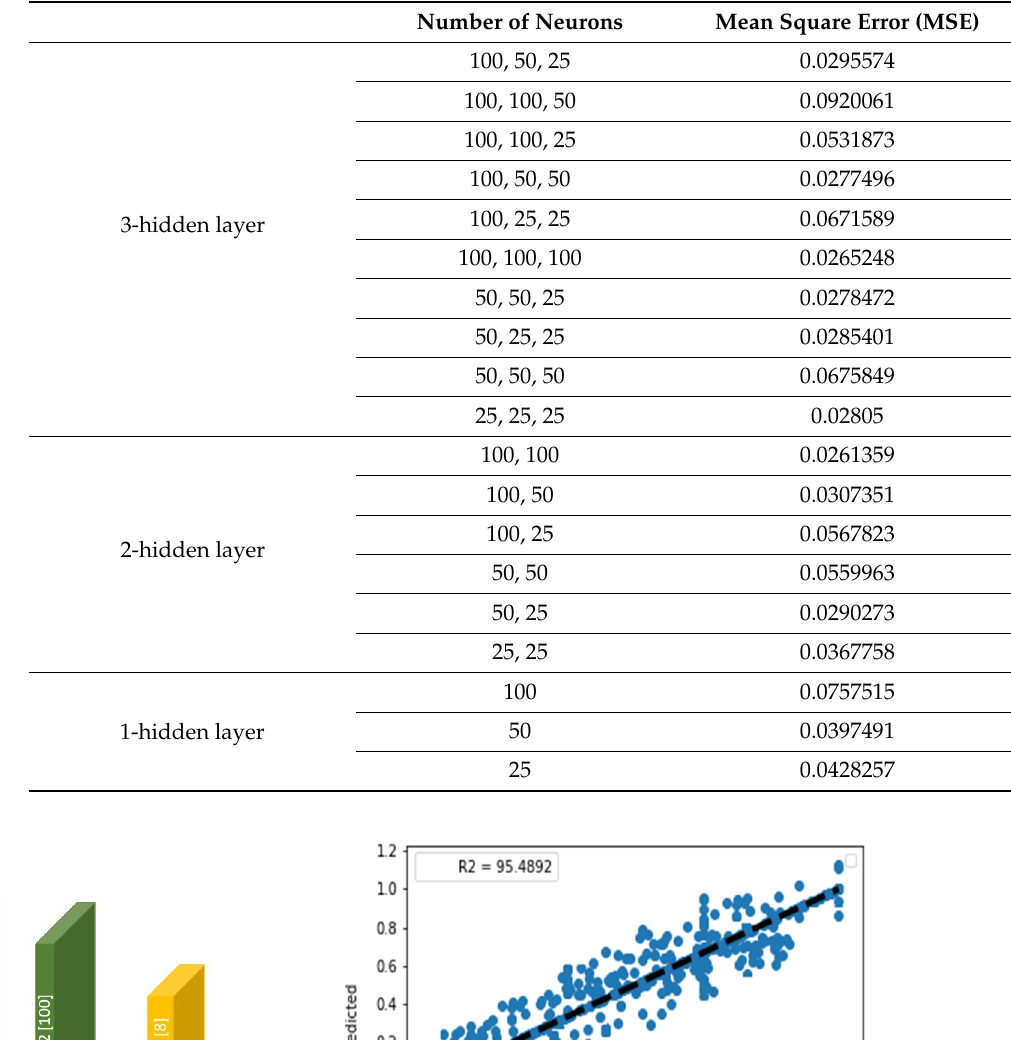
Table 3. Grid-searching neural network designs for ML hyperparameter optimization.